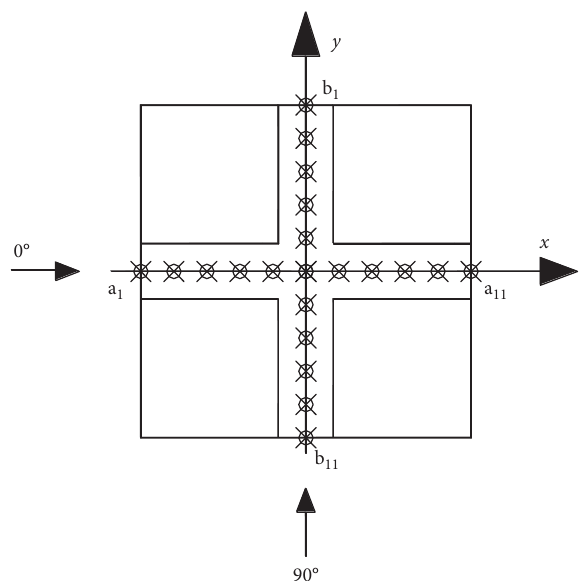
Figure 3: Monitoring points in the opening and wind direction